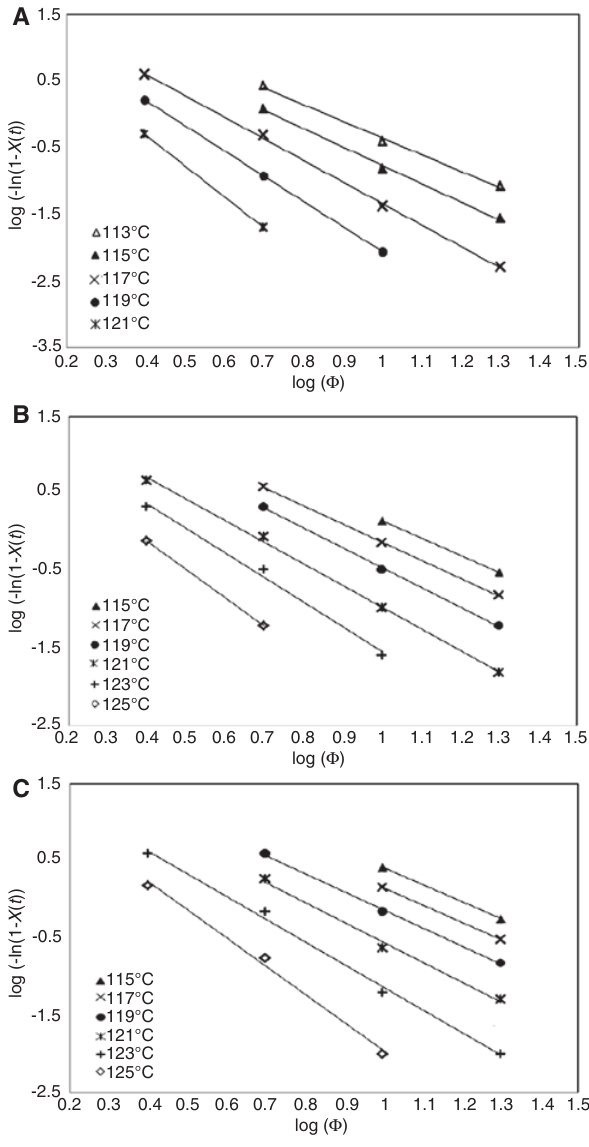
Figure 5: Ozawa plots of log [-ln (1- X ( t )] vs. log( Φ ) for non-isother- mal crystallization of (A) neat polypropylene (PP), (B) PP-25 date palm fiber (DPF)-5MA and (C)